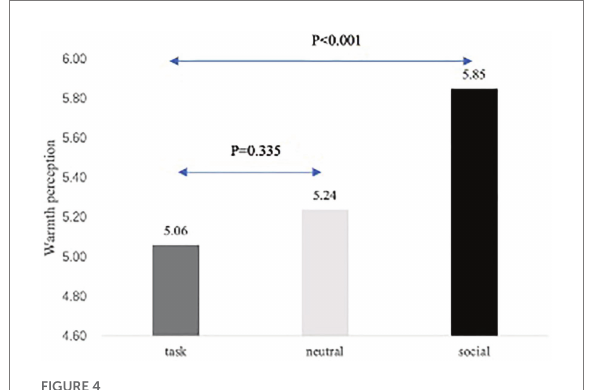
FIGURE 4 Mean values for warmth perception for pretest.